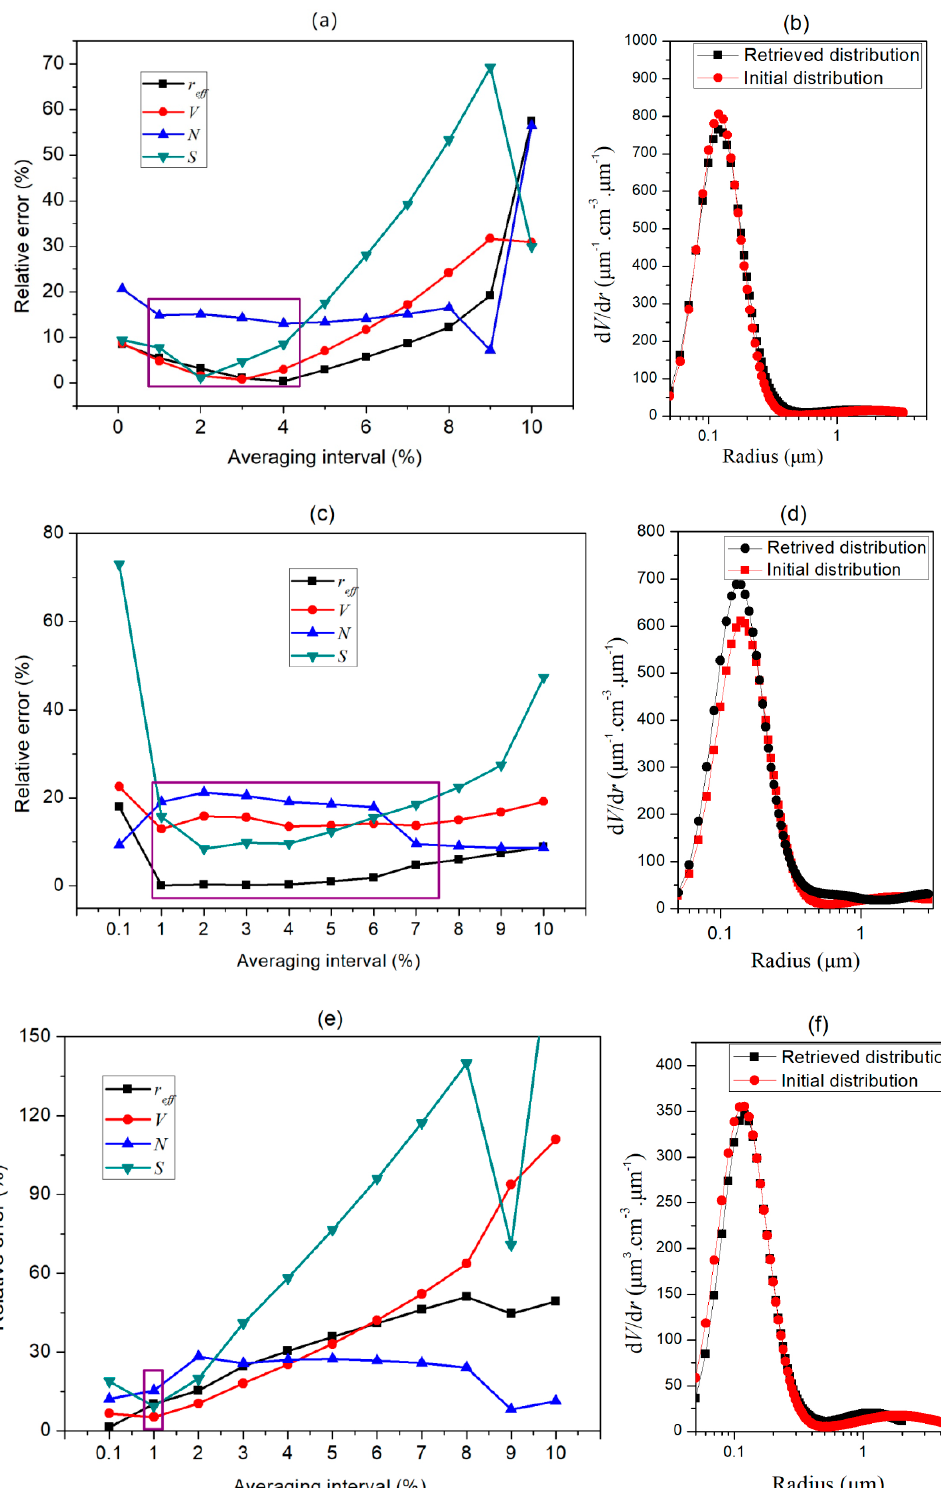
Figure 2. Estimation errors for number ( N ), surface ( S ), volume ( V ) concentration, particle effective radius r eff , and averaged discrepancy as a function of the averaging interval for three main types of aerosols ( a , c , e ). Additionally, the retrieved volume size distribution (black square–solid line) for ( b ) urban industrial aerosol distribution, ( d ) biomass burning aerosol, and ( f ) desert dust/oceanic aerosol and their initial bimodal aerosol size distributions (red dot–solid line) are shown. The purple squares represent the chosen averaging interval of ρ ave .